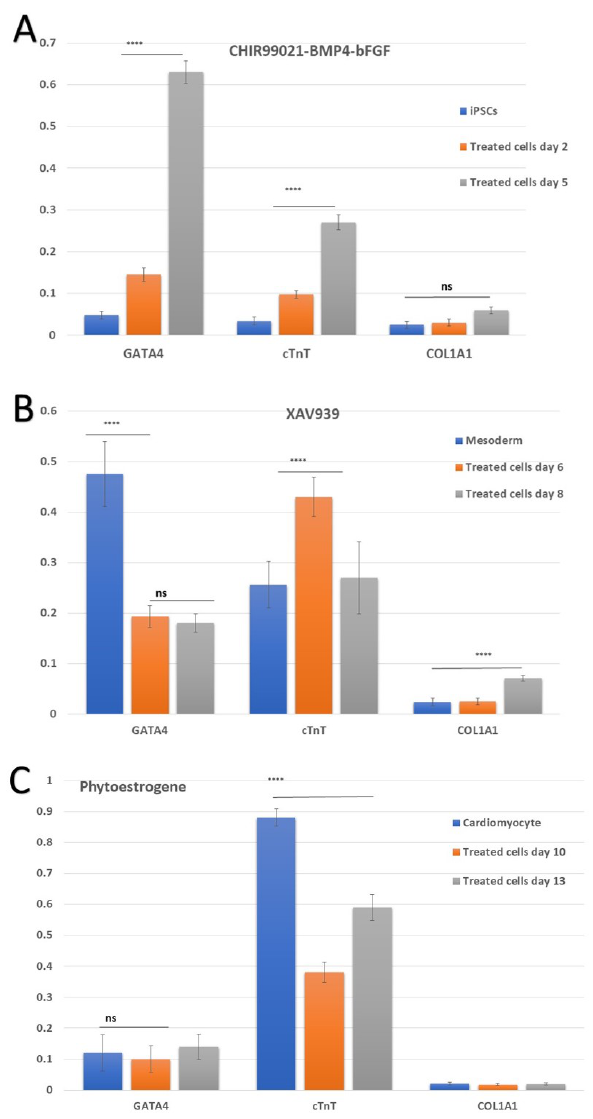
Fig. 4. Comparison of specific cardiac gene expression in all remedies and control group after treatment . (A) The addition of CHIR99021-BMP4-bFGF cocktail significantly increased the expression of mesoderm-related gene GATA-4 ( p = 0.003) com- pared to the control on day 2 and iPSCs, but the concentration of cardiomyocyte-associated gene cTnT was relatively low ( p = 0.009) and the expression of bone-related gene Col1A1 is neg- ligible. (B) On the day 6-8 of differentiation, the addition of XAV939 upregulated cTnT and downregulated GATA-4 markers ( p = 0.018). (C) After the addition of phytoestrogen extract until day13, cTnT gene expression increased significantly compared to day 6 ( p < 0.01). ∗∗∗∗ Significant; ns, non-significant.